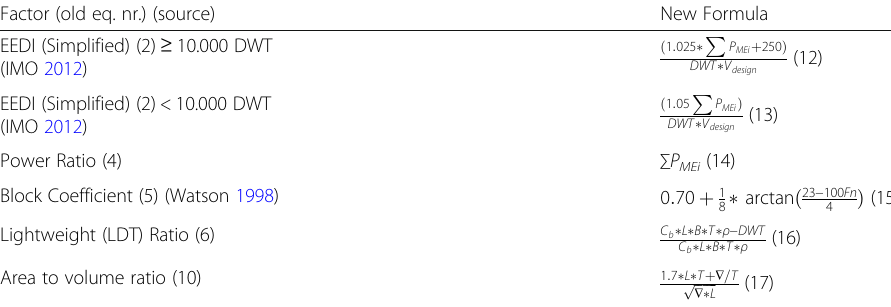
Table 2 Overview of the updated factor formulas Factor (old eq. nr.) (source) New